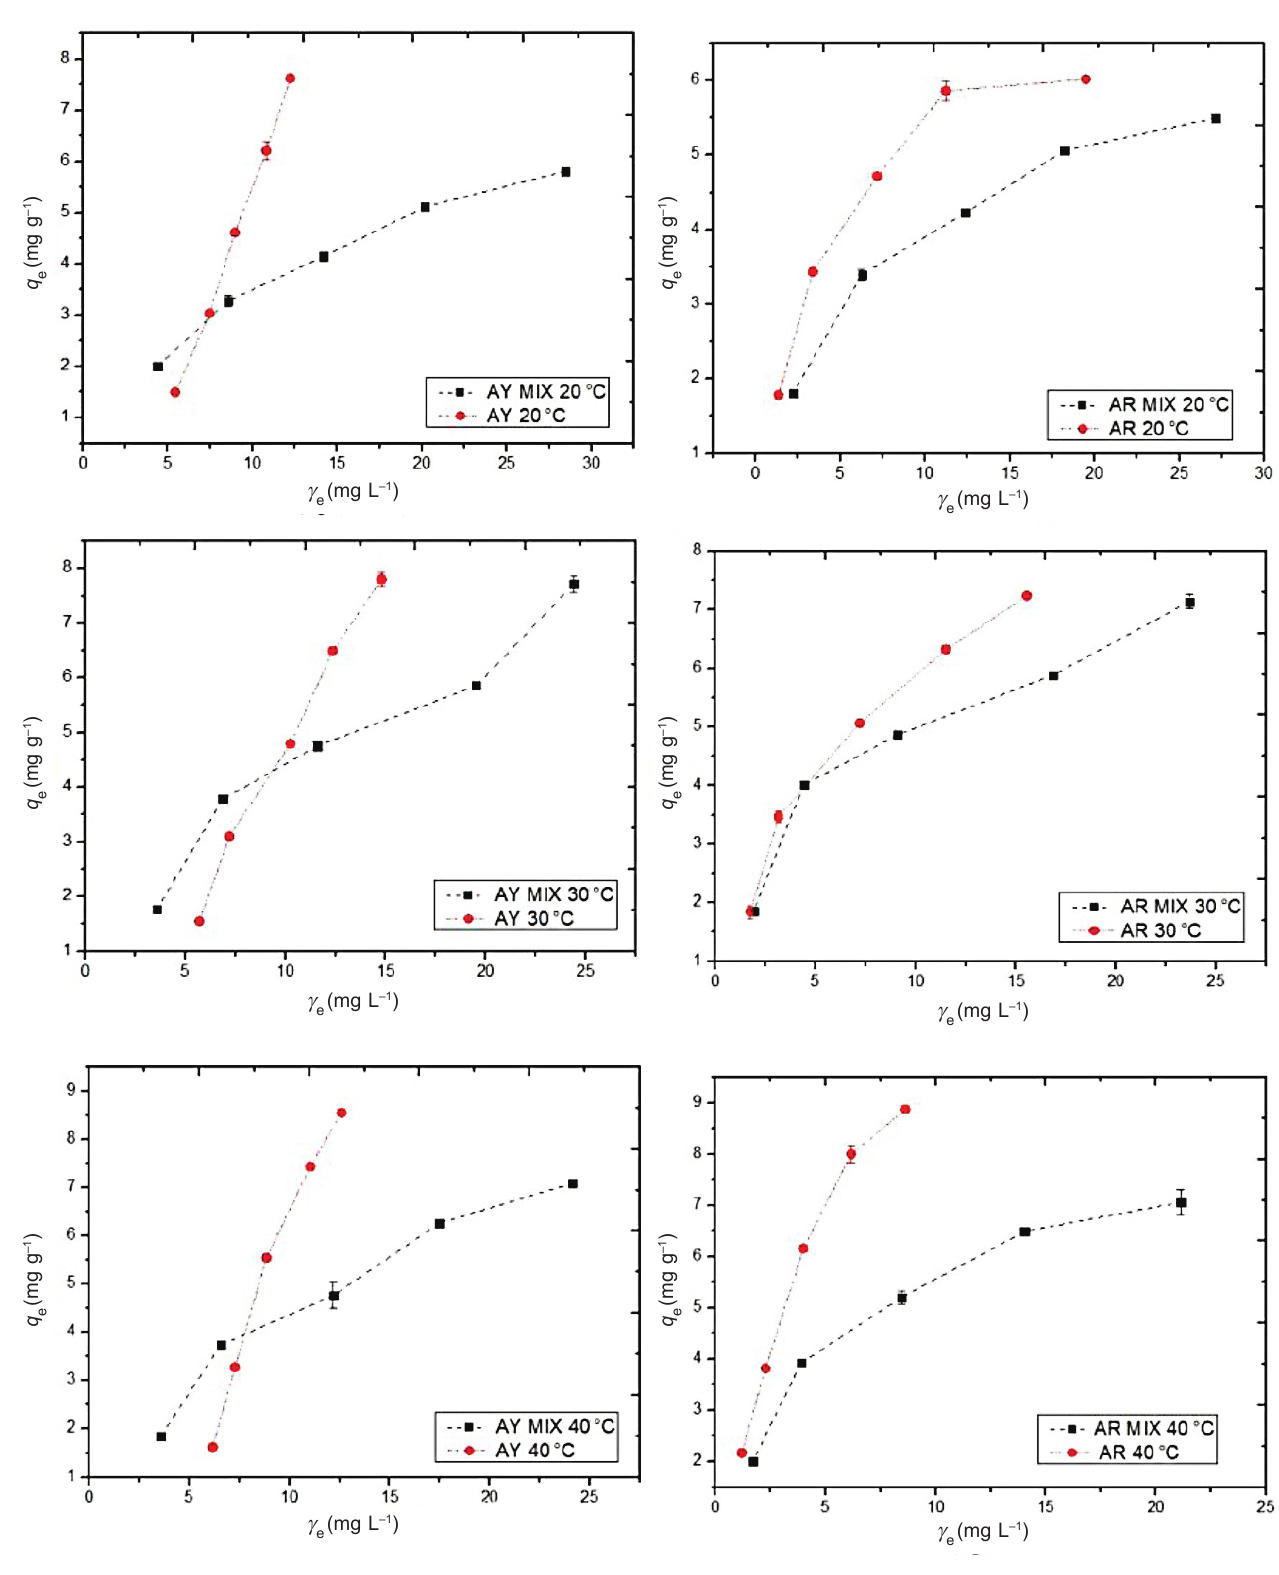
Fig. 6 – Effect of temperature (20, 30, and 40 °C) and dye concentration of Açaí seeds powder biosorption capacity : equilibrium biosorption capacity; γ : Equilibrium concentration of the solution; AY: Acid yellow dye single solution; NOTE: q e e AR: Acid red dye single solution; AY MIX: Acid yellow dye binary solution; AR MIX: Acid red dye binary